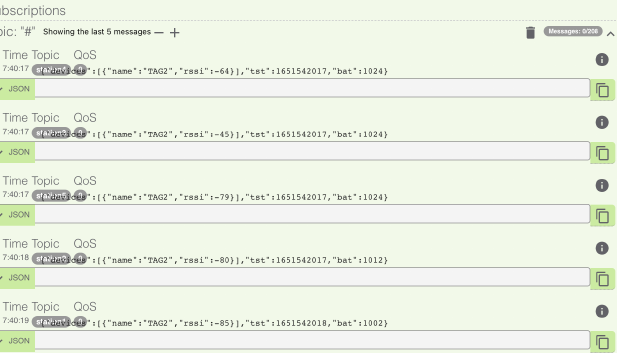
Figure 15. Final implementation of TAG device (front and back) and NRFConnect App (taken from [24]).